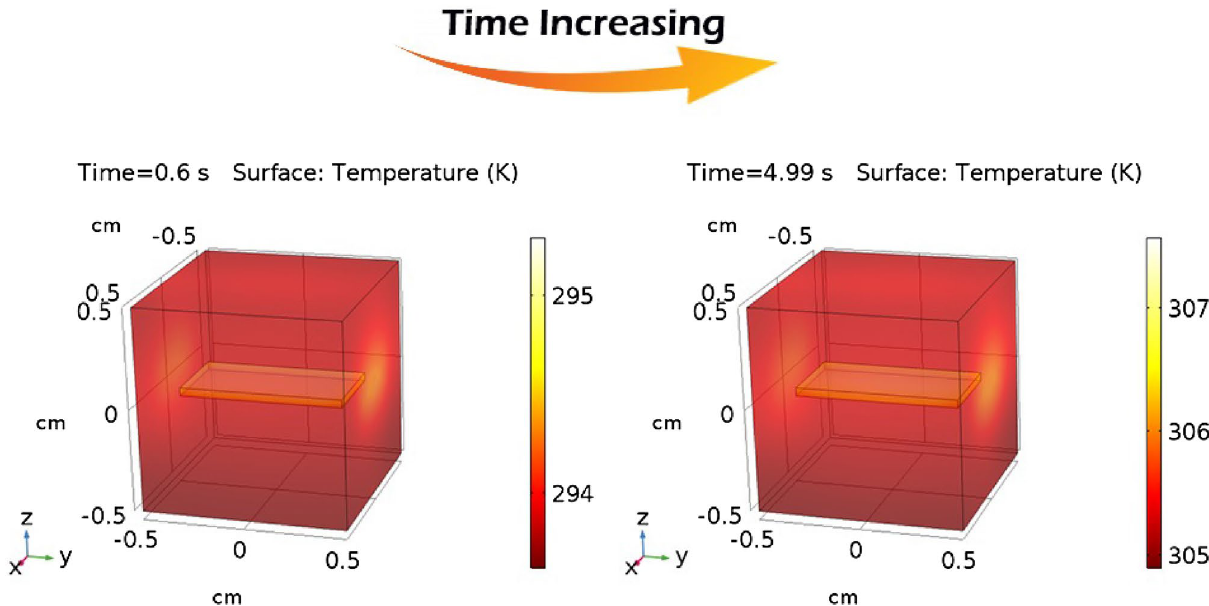
Figure 3. Temperature profile of geometry at two different simulation